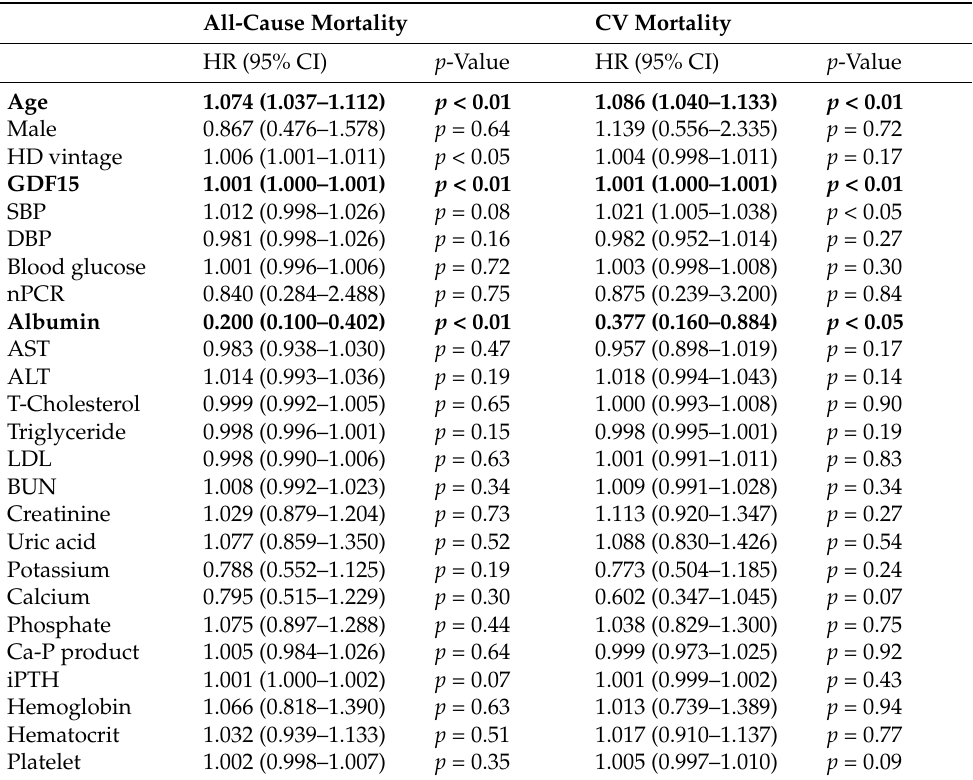
Table 2. Age, GDF15, and albumin as significant prognostic parameters for all-cause and CV mortality in the univariate Cox regression analysis.